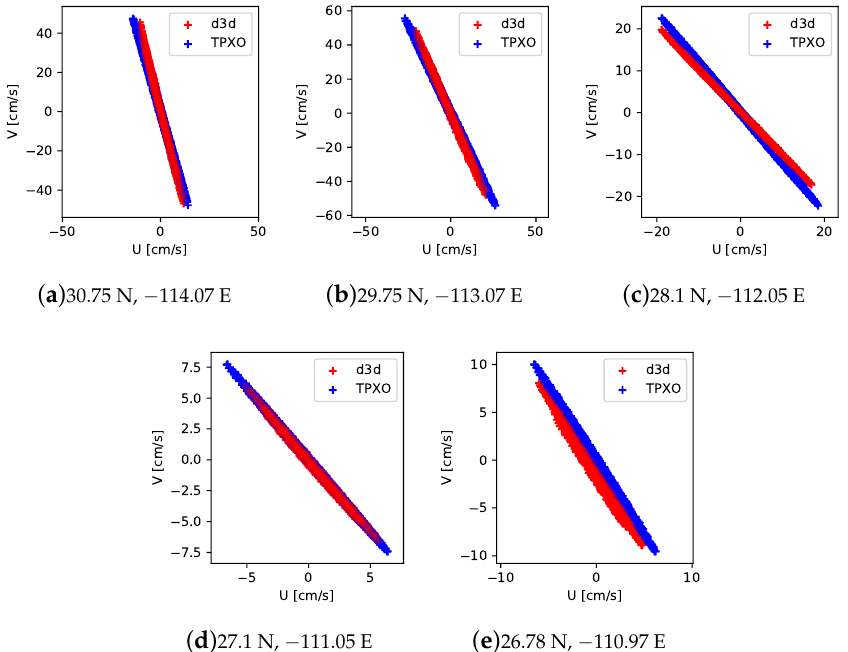
Figure 11. Scatter plot of U versus V components of the barotropic